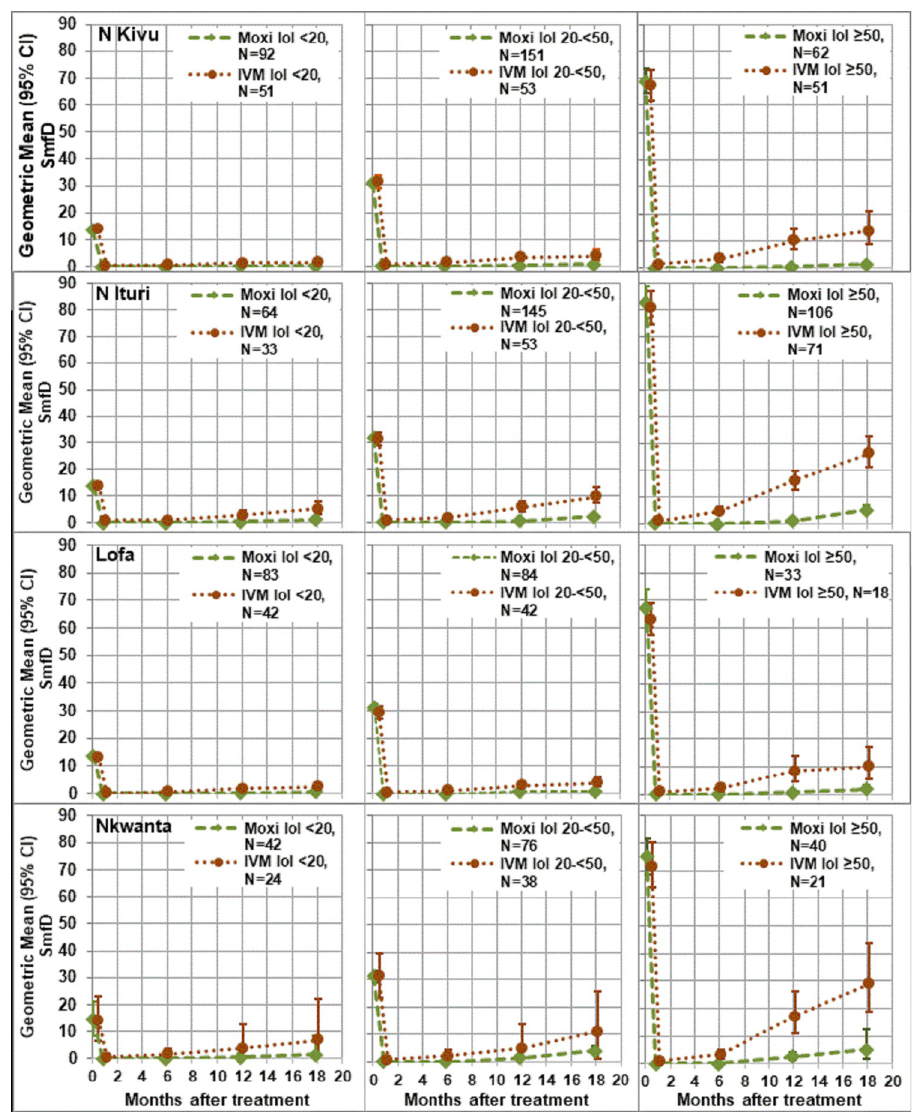
Fig 3. Geometric mean (95% CI) SmfD by intensity of infection category and study area. Moxi: moxidectin, IVM: ivermectin, N: number treated (for number with follow up data at each time point, see Tables S4-S8 in S 1 File ), IoI intensity of infection: < 20: 10- < 20 mf/mg skin; 20–50: 20- < 50 mf/mg skin, � 50: � 50 mf/mg skin pre-treatment.